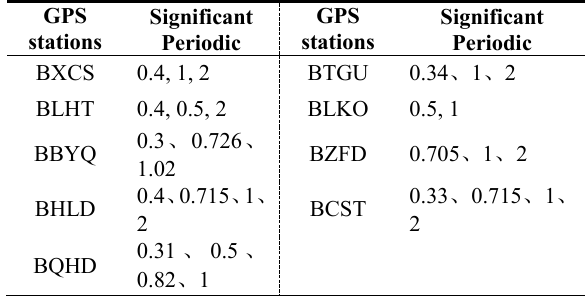
Table 2. Result of Significant Periodic Inspection （ 𝑭 𝜶 =2.99